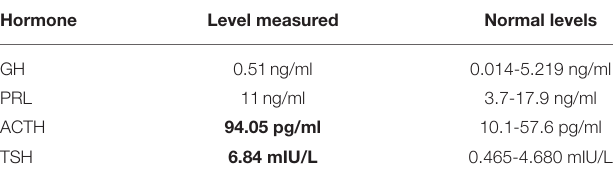
TABLE 1 | Endocrine examination results.